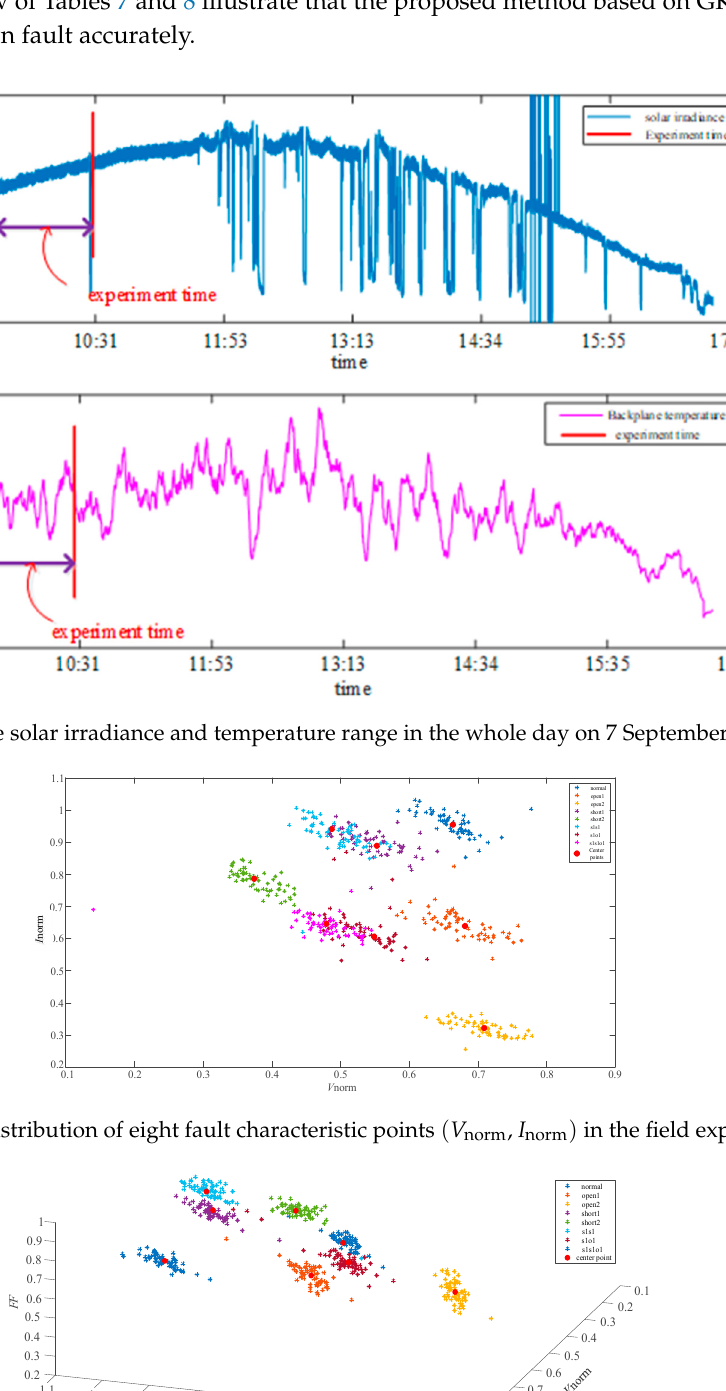
, V I in the field experiment. norm norm , , V I FF and clustering center norm norm , , V I FF and clustering center norm norm